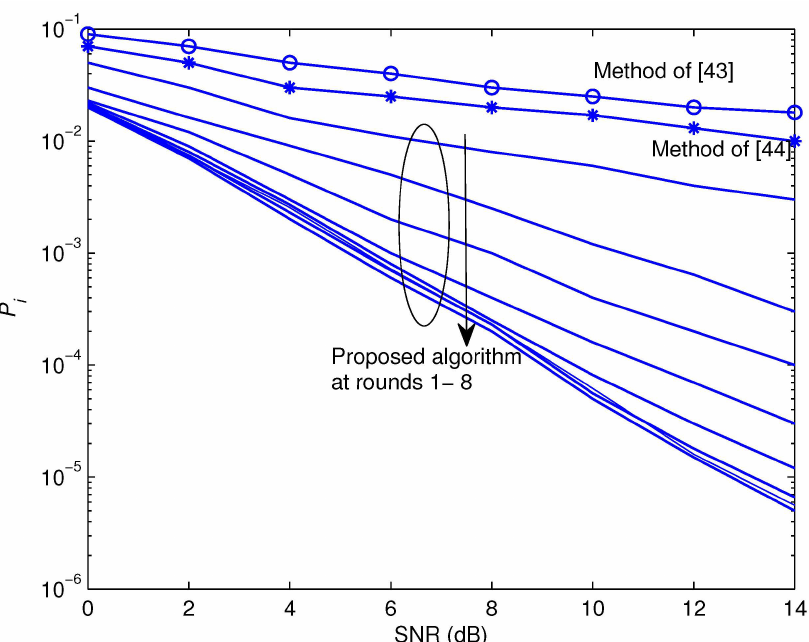
Figure 3. The probability of improper classification P i of the proposed classifier in comparison to the works of [43,44]. The system’s parameters are U = 4, N = 2048, (cid:104) Φ ( u ) (cid:105) = 512, u = 0,1,2,3, ν = 11, χ = 60; 10 channel paths; convolutional codes of rate 0.5; interleaved sub-carrier mapping; STBC set of S1, S2, S3, S4, and S5; and a modulation set of 4-QAM, 16-QAM, 64-QAM, 128-QAM, 256-QAM, and 512-QAM.